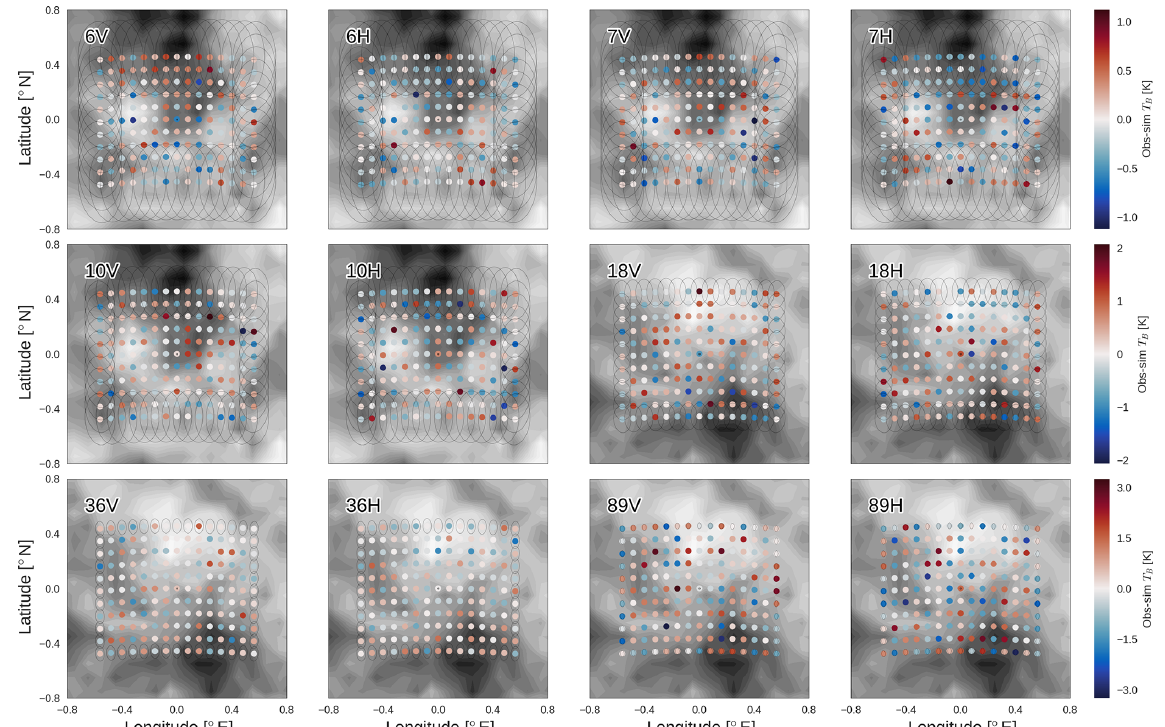
Figure 5. Observed minus simulated T B for the 12 AMSR2 channels used in the 2D-Var for the synthetic scene. Channel names are given in each panel. Backgrounds of each panel show contours of the SST (6–10GHz, first six panels) and WSP fields (18–89GHz, last six panels), echoing Fig. 3. FOVs for each channel are shown in black as ellipses for edge